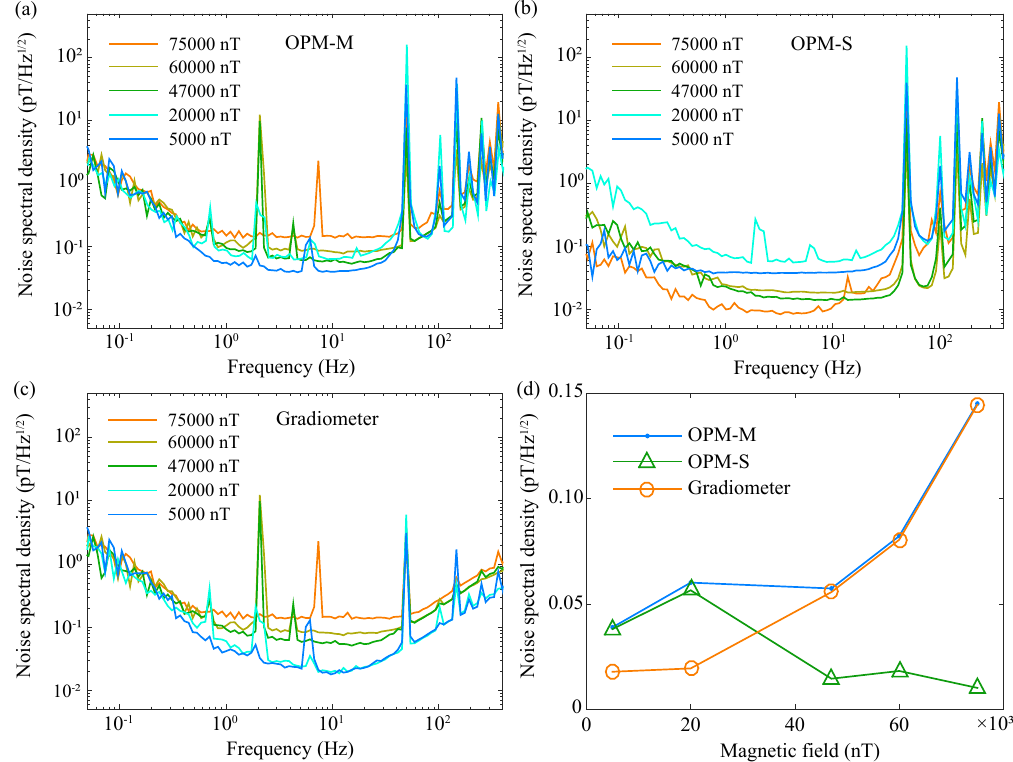
Figure 4. Noise spectral density (NSD) measured with the OPM sensors after active magnetic-field stabilization under different strength of bias magnetic field. ( a ) The NSD of OPM-M sensor, i.e., the magnetometer used for monitoring the magnetic-field noise after magnetic-field stabilization. ( b ) The NSD of OPM-S, i.e., the magnetometer used for magnetic-field stabilization. ( c ) The NSD of the gradiometer. ( d ) The NSD of OPM-M, OPM-S, and the gradiometer at 10 Hz under different strength of bias magnetic